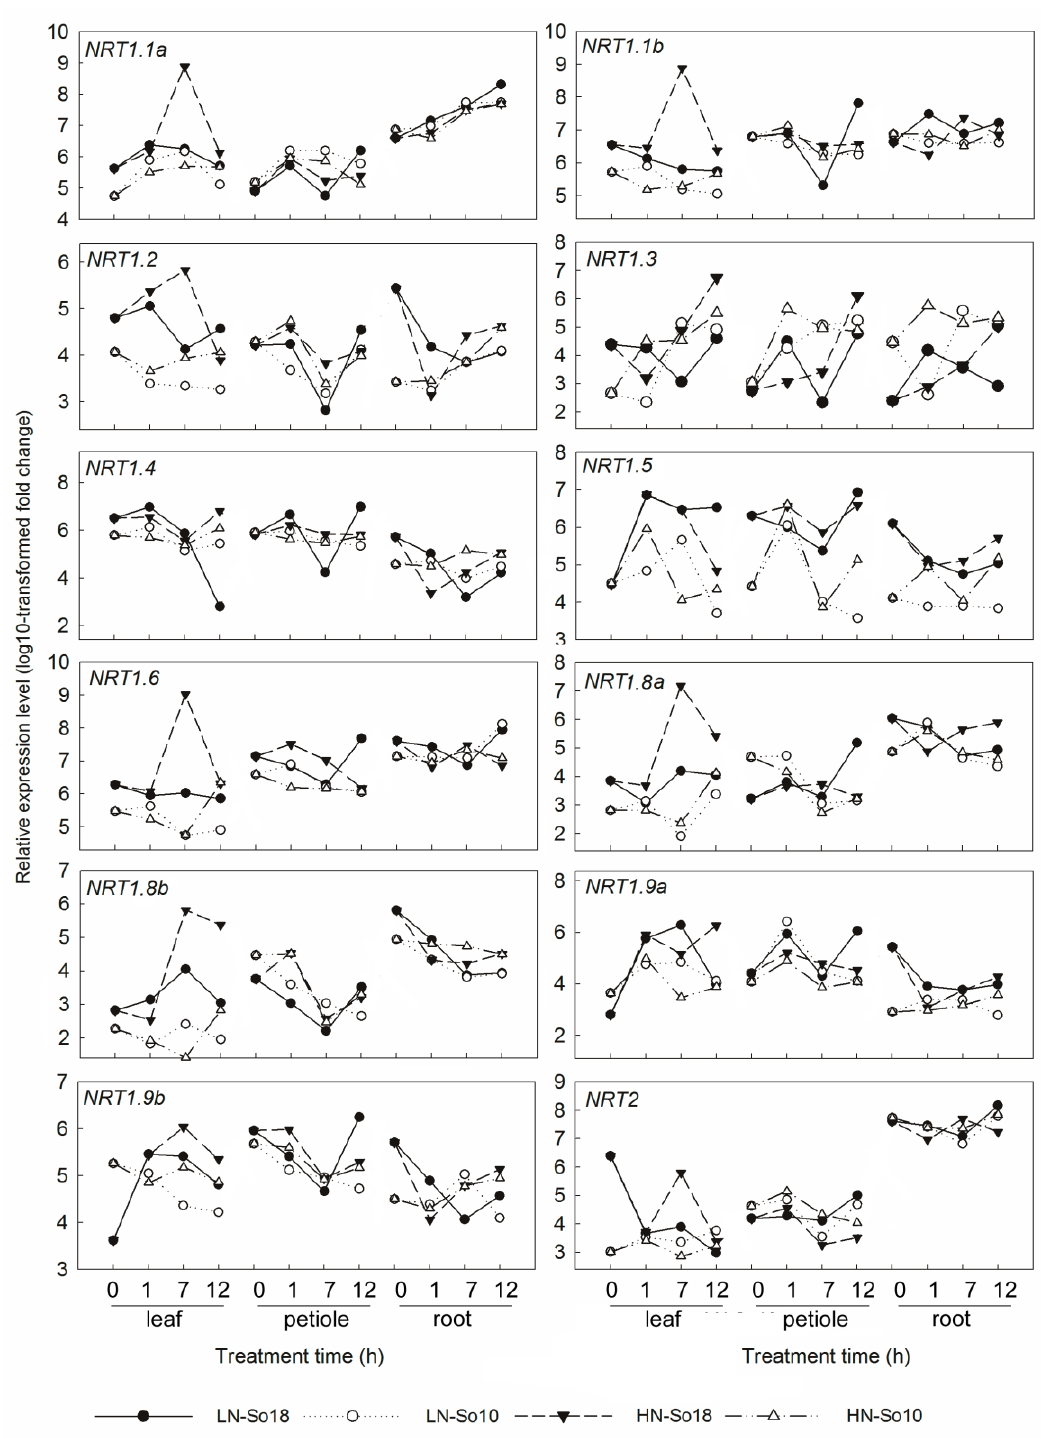
Figure 6. Expression analysis of genes encoding nitrate transporters in leaf blades, petioles and roots of two spinach varieties under two concentrations (0.5 and 15 mmol·L −1 ) of nitrate treatments by qRT-PCR. All values represent the averages of three replicates (see Supplementary Table S1 for details). LN-So18, So18 treated with low nitrate concentration; LN-So10, So10 treated with low nitrate concentration; HN-So18, So18 treated with high nitrate concentration; and HN-So10, So10 treated with high nitrate concentration.